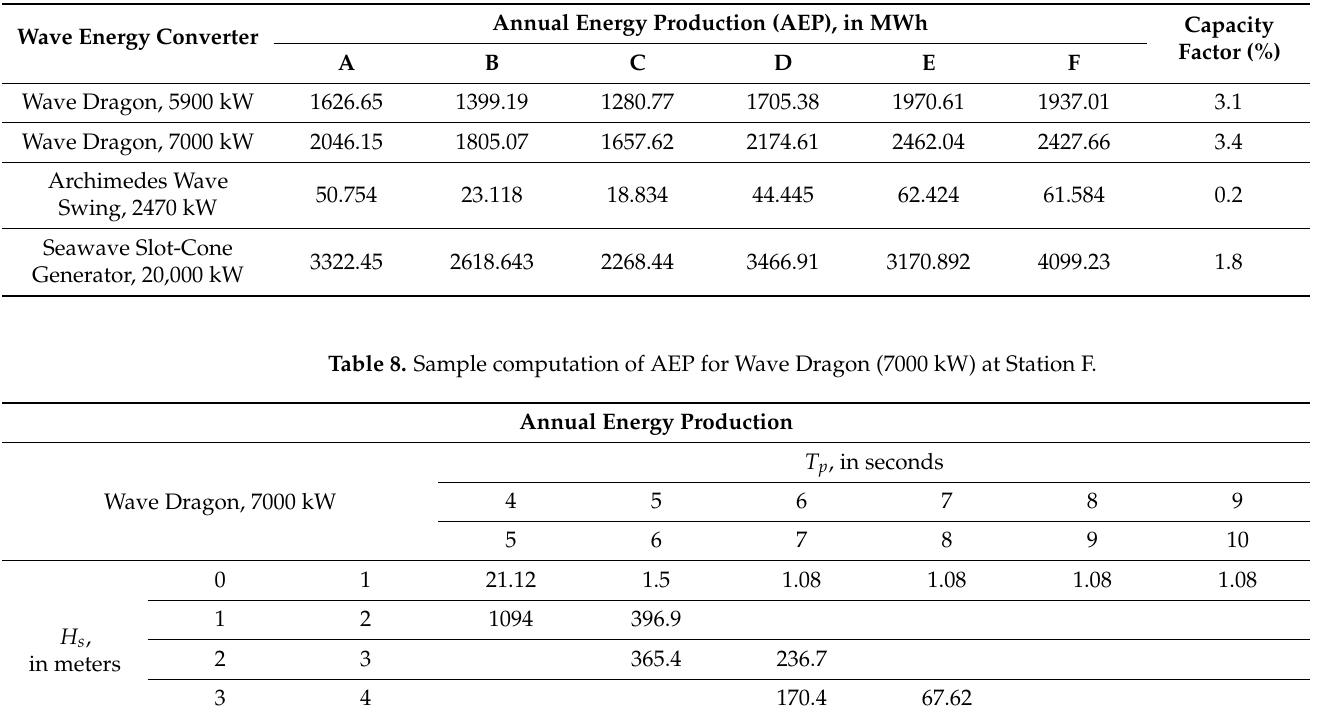
Table 7. AEP results of Wave Dragon, AWS and SSG, in MWh.